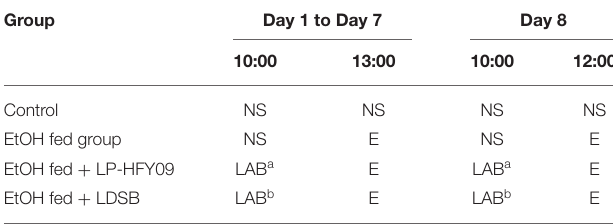
TABLE 1 | Treatment during the